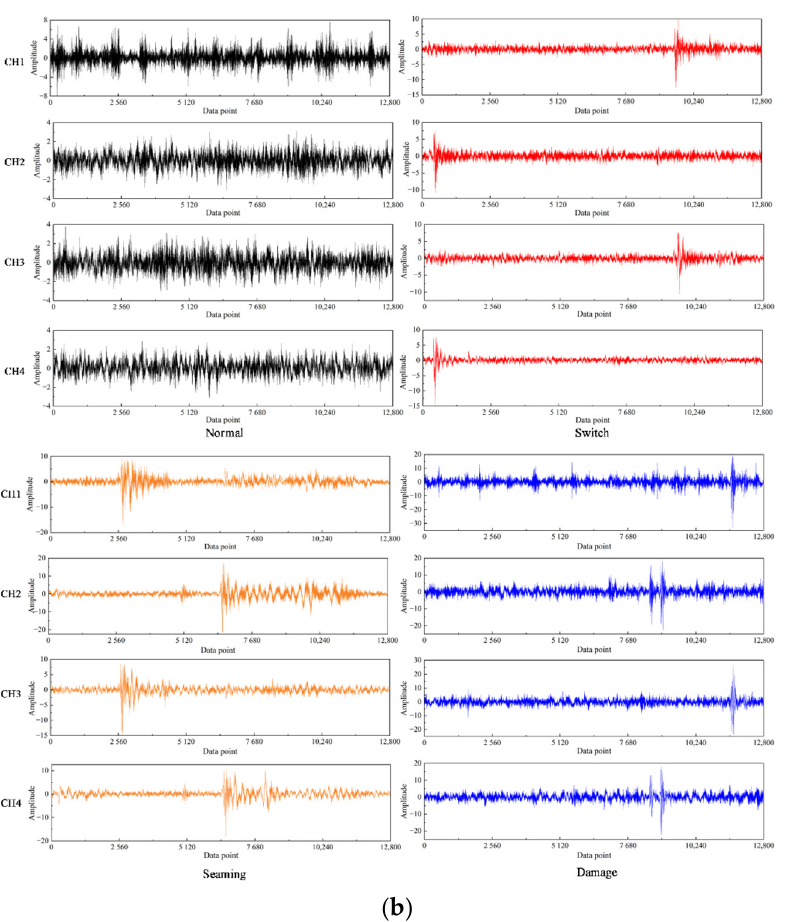
Figure 5. Schematic diagrams and waveforms of four sections under different four channels. ( a ) Schematic diagram of four sections. ( b ) Vibration signal waveform diagram.